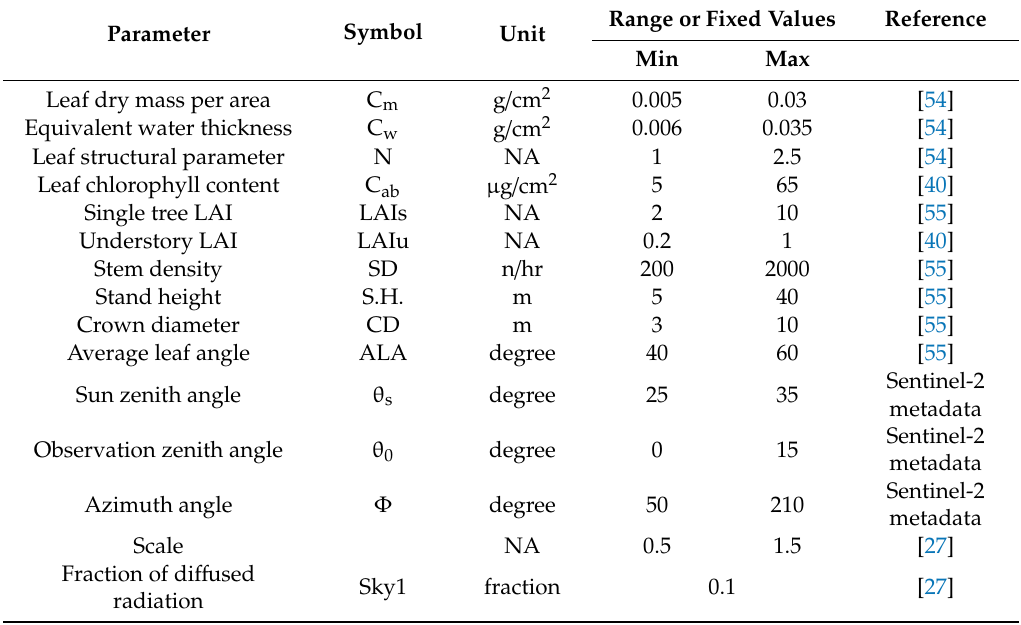
Table 3. INFORM input parameters used to build the LUT. The inputs were defined through the literature review and sensor configuration of